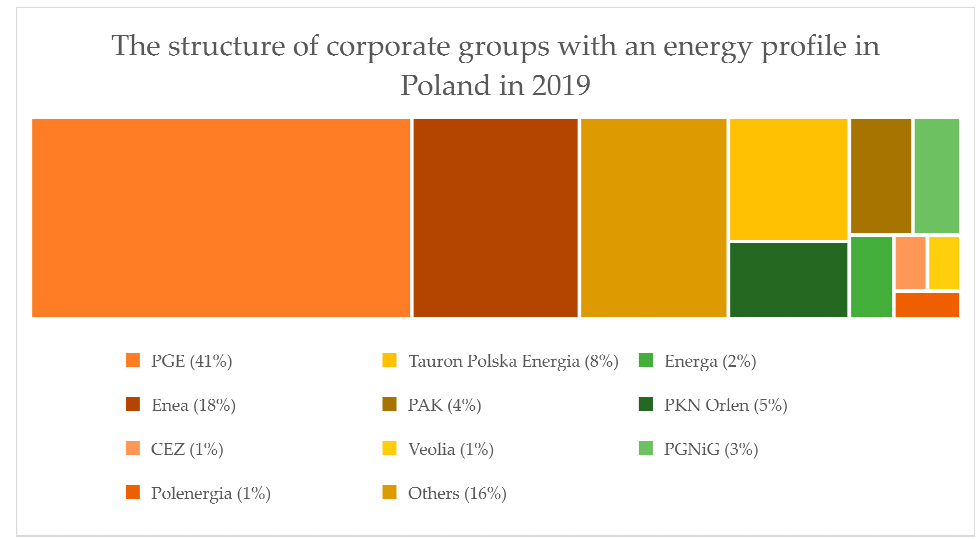
Figure 1. The structure of corporate groups with an energy profile in Poland in 2019. Source: authors’ own studies, developed from [38].